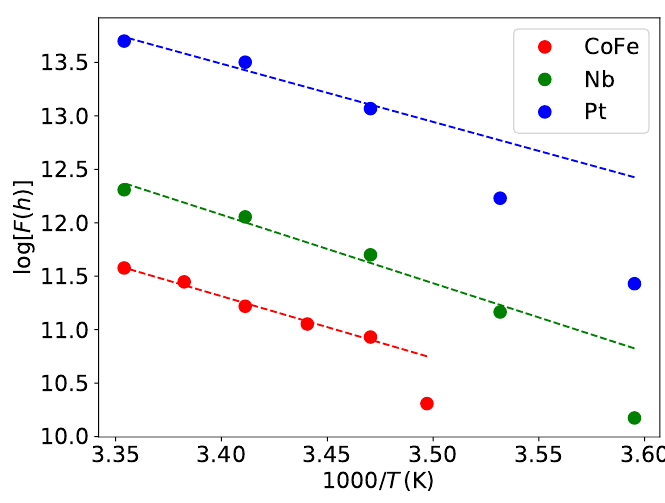
Figure 4. Logarithm of F ( h ) , as defined in Equation (5), plotted vs. 1/ T for the CoFe-, Nb-, and Pt-precursor as indicated. The dashed lines represent linear fits of the data excluding the lowest temperature data point for the CoFe and Nb deposits and the two low-temperature data points for Pt deposits.